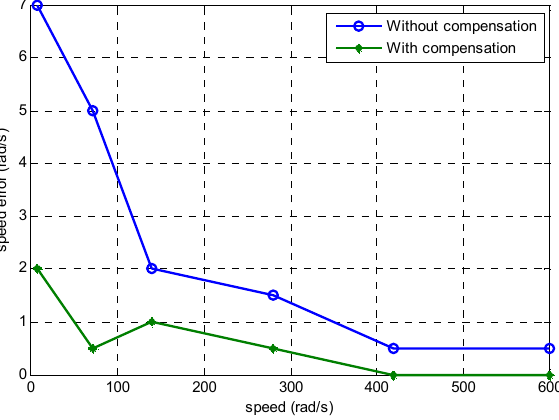
Figure 18. The experimental results of actual speed and observer speed at 623 rad/s.